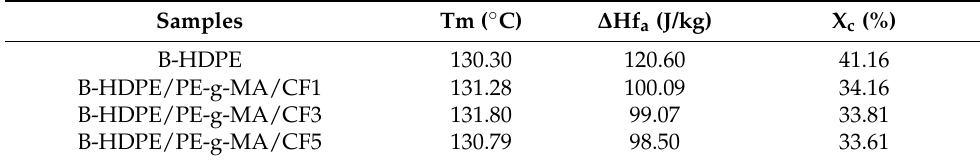
Table 2. DSC results of B-HDPE and biocomposites.